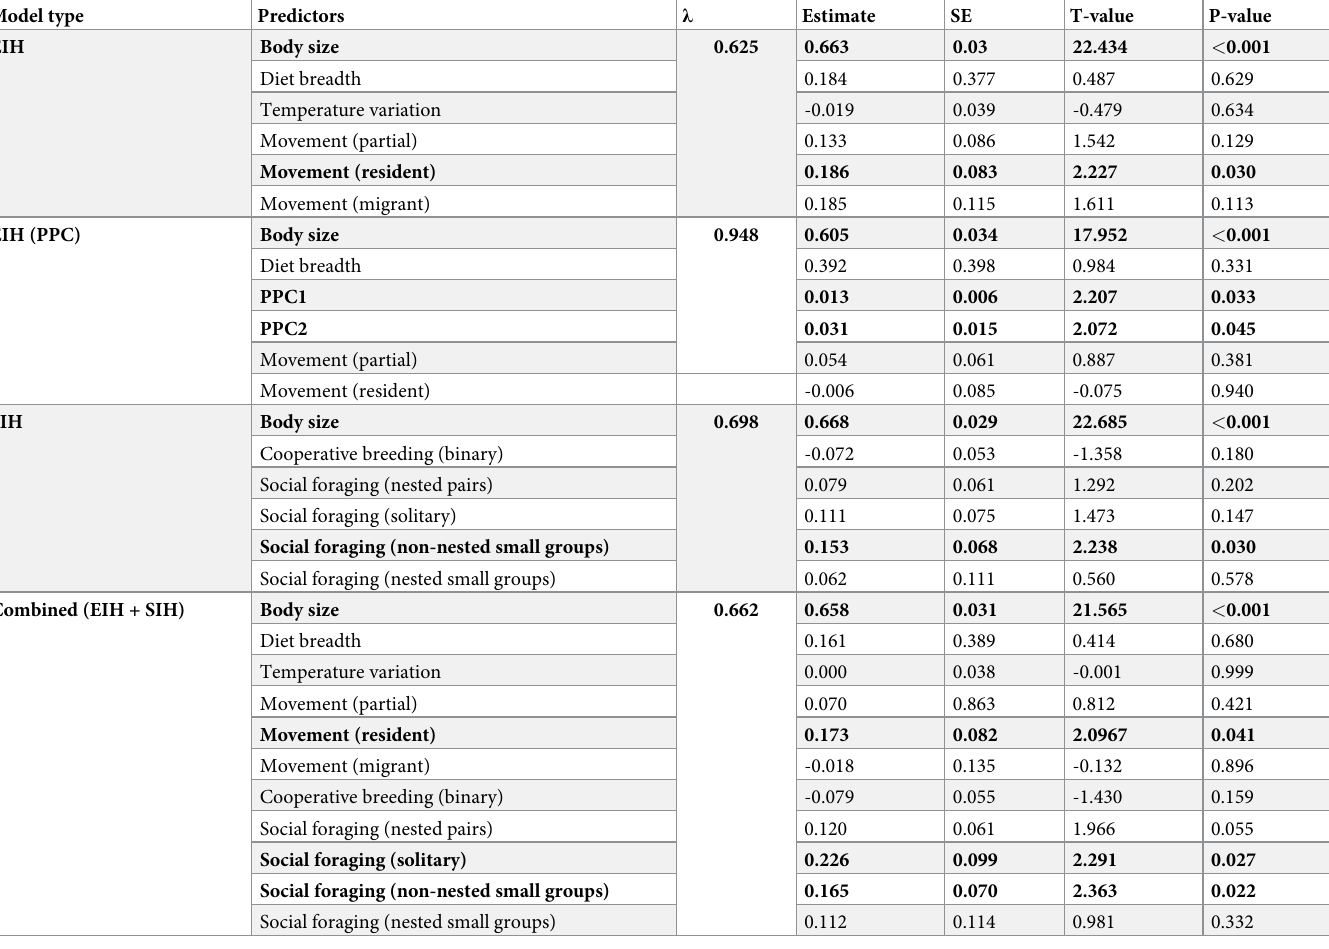
Table 2. Phylogenetic generalised least squares model results, comparing different model formulations. All significant pairwise contrasts for categorical variables are presented. Significant predictors are shown in bold. Model